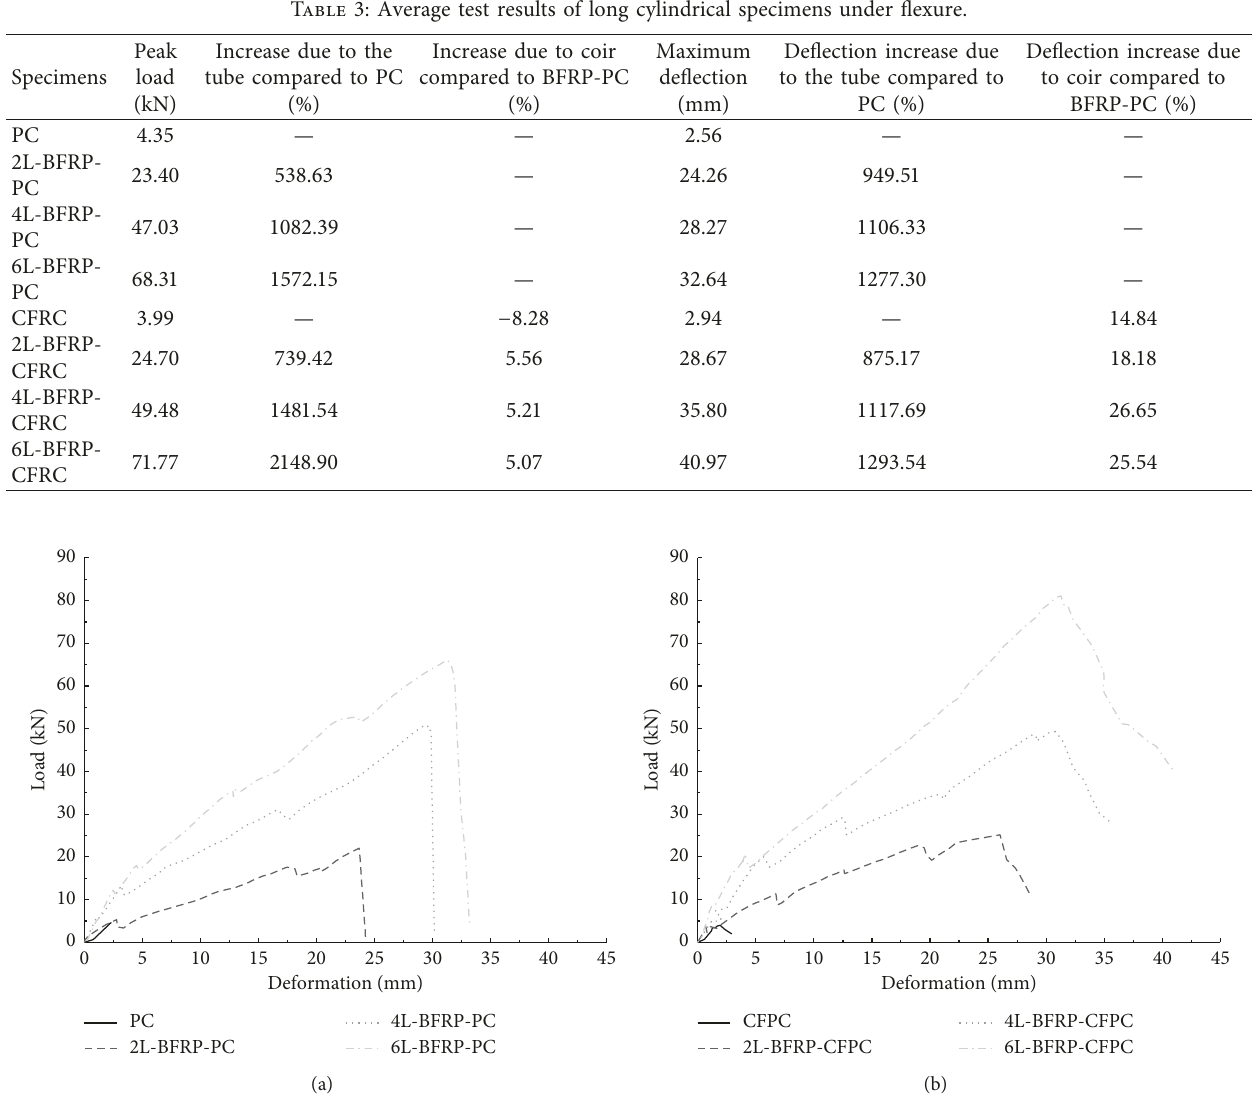
Figure 4: Load-displacement relationship. (a) PC and BFRP-PCs. (b) CFRC and